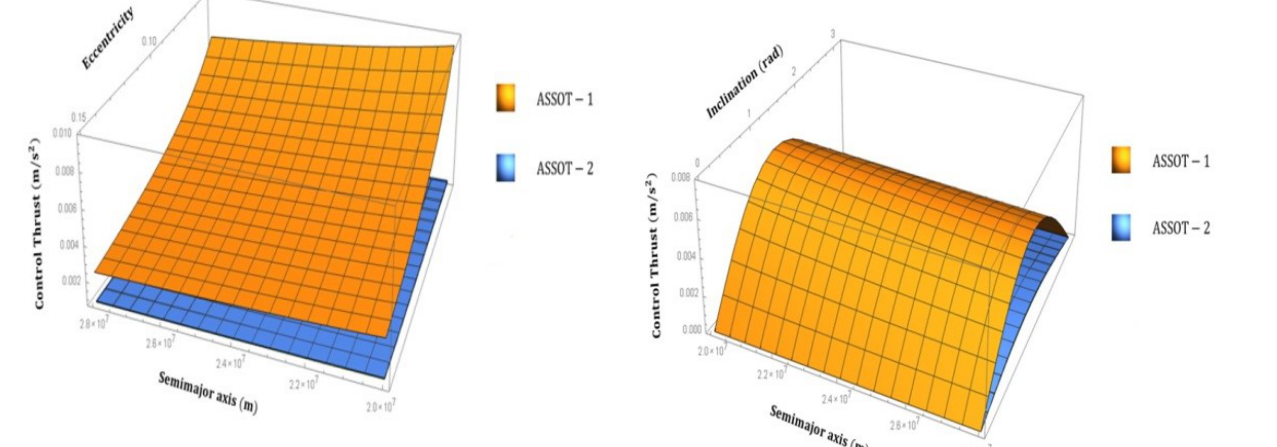
Figure 6. Control thrust vs. semimajor axis and eccentricity for all techniques